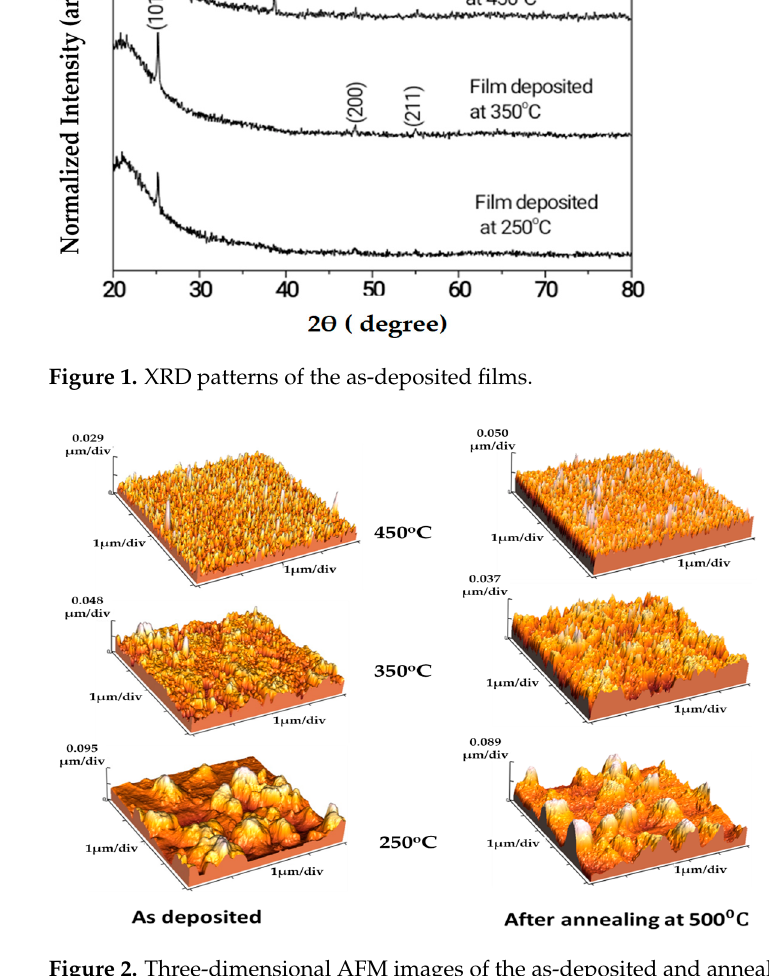
Figure 1. XRD patterns of the as-deposited films.